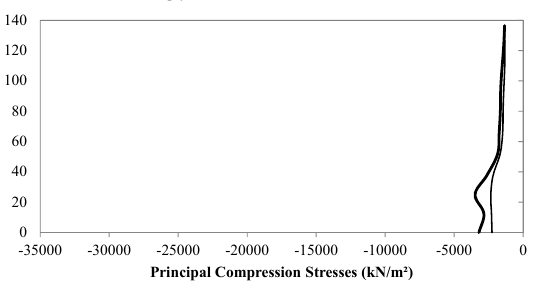
Fig.23. The maximum principle stress components in V-V section. Fig. 23. The maximum principle stress components in V-V